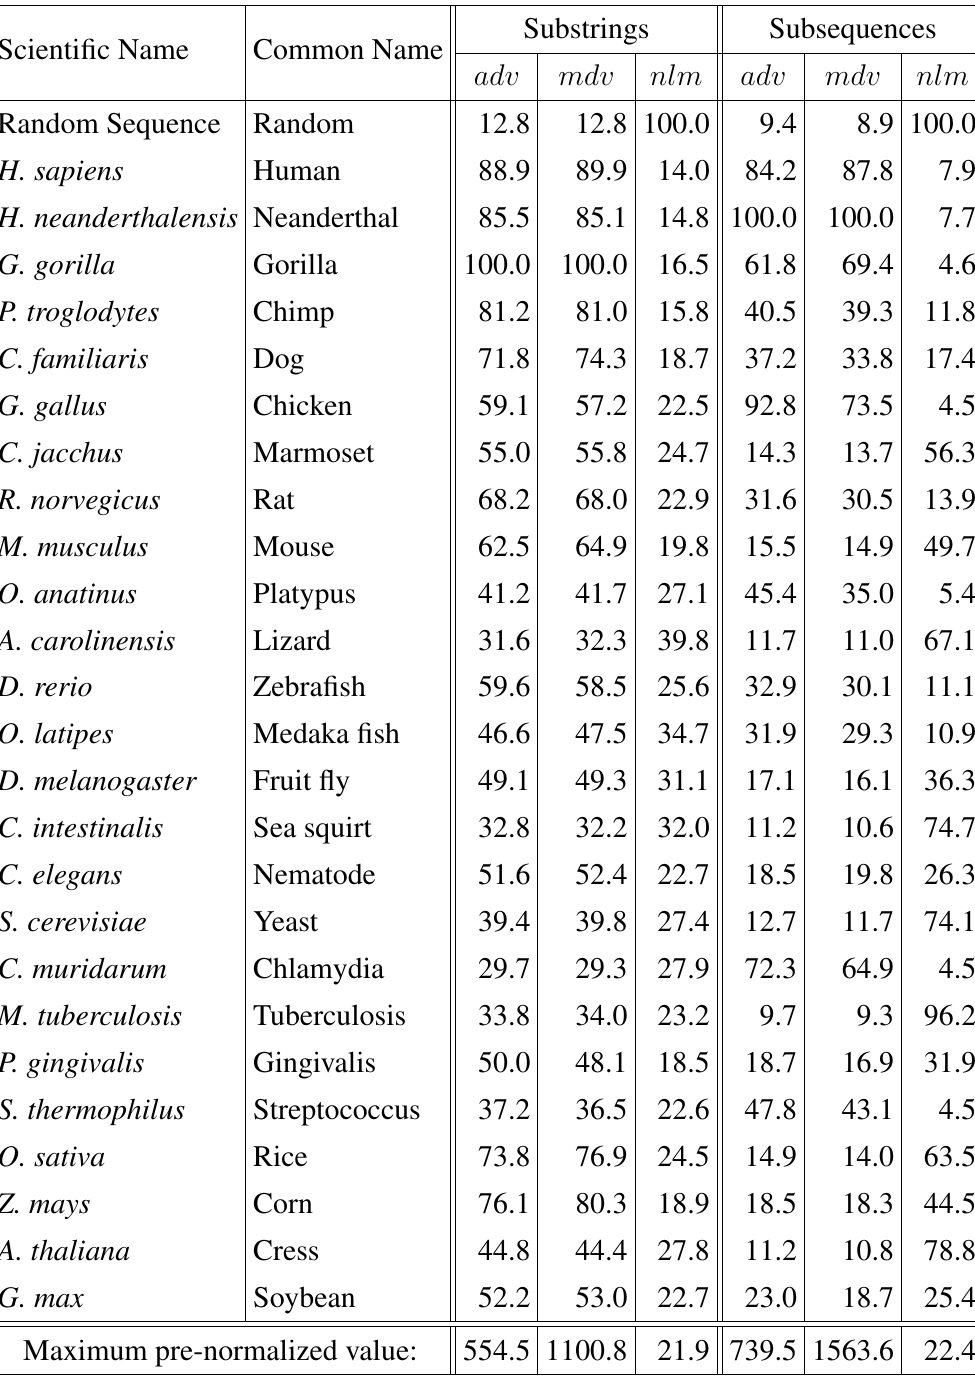
Table 1: Normalized averages of 1,000